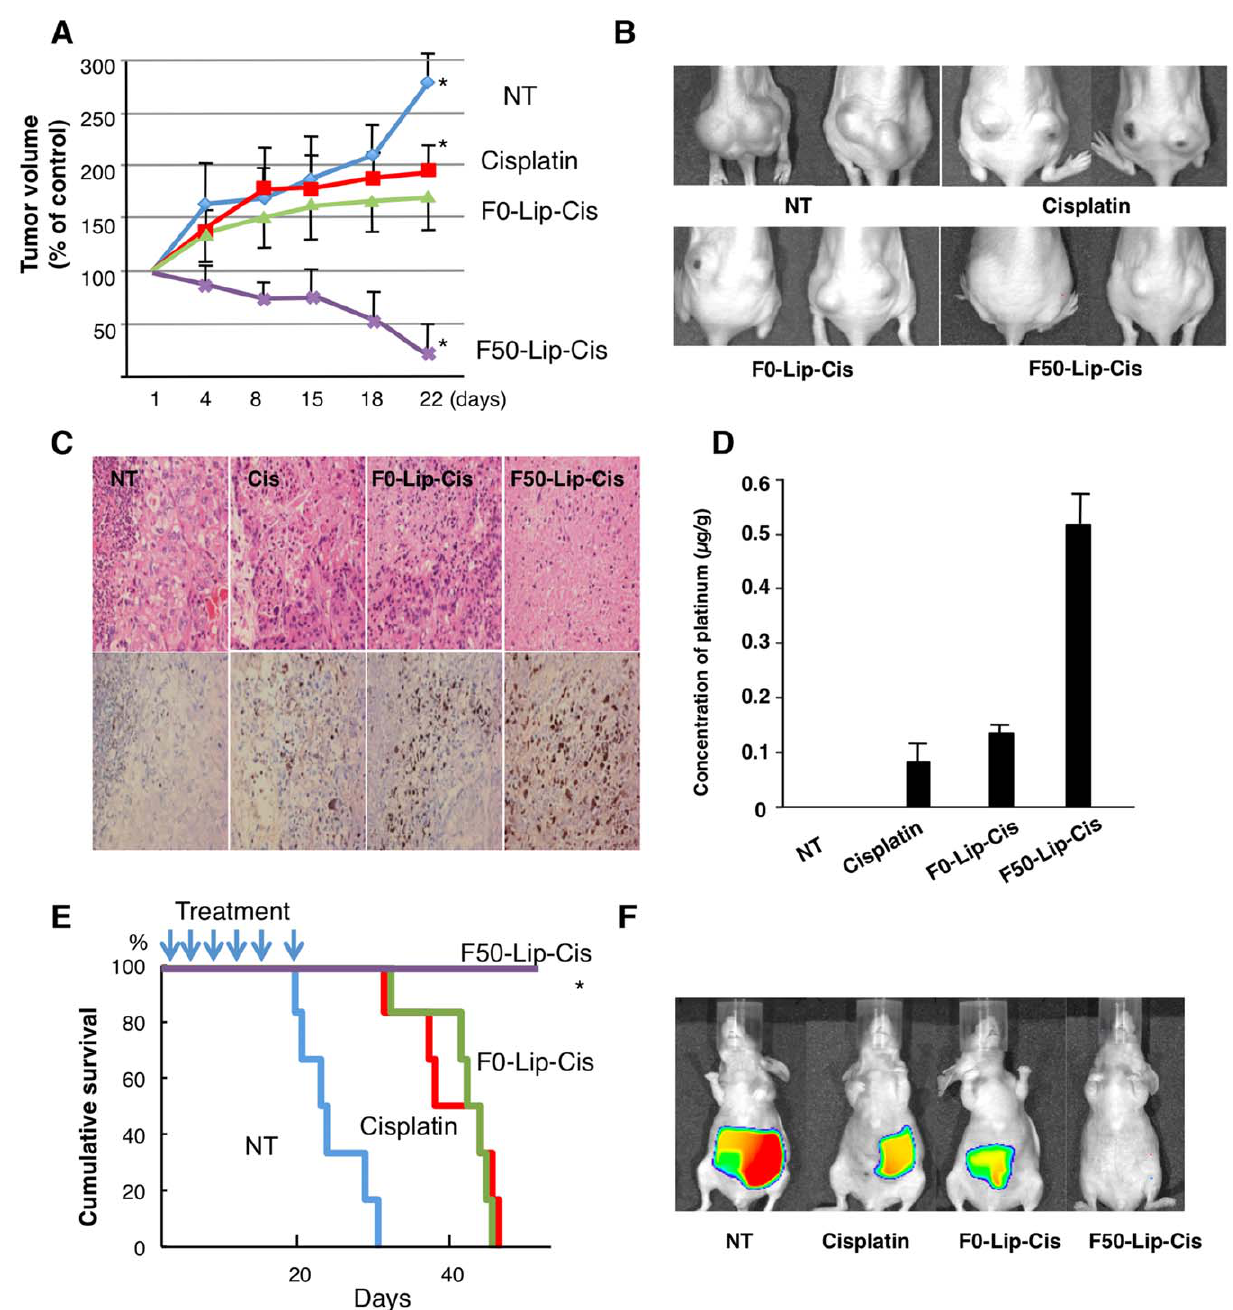
Figure 6. Fuc-liposomes carrying Cisplatin suppressed tumor growth and prolonged survival of mice in the xenograft model. ( A, B ) Comparison of tumor growth suppression with Cisplatin, F0-Liposome-Cisplatin, and F50-Liposome-Cisplatin in AsPC-1-bearing mice. Cisplatin (2 mg/ kg), F0-Liposome-Cisplatin (2 mg/kg), or F50-Liposome-Cisplatin solution (2 mg/Cisplatin/kg) was injected via the tail vein of AsPC-1-bearing mice twice a week. At 4, 8, 11, 15, 18 , and 22 days after transplantation, tumor volumes were measured. Representative image of mice treated with Cisplatin ( B ). Results are expressed as the mean 6 SD (n=6). *P , 0.01 compared with NT, Cisplatin, and F0. ( C ) Tumor tissue was prepared on day 22 after treatment. HE staining (upper panel) and TUNEL staining (lower panel) are presented. ( D ) Concentration of platinum in the tumor tissue measured by ICP. ( E ) Survival rate of the mice treated with Cisplatin alone, F0-Liposome-Ciplatin, and F50-Liposome-Ciplatin in the liver metastasis model using BxPC-3 cells. Statistical analysis was performed by generalized Wilcoxon test. *P , 0.01 compared with NT, Cisplatin, and F0. ( F ) Localization of BxPC3-Luc cells in the orthotopic model detected using an IVIS imaging system after 3 weeks of treatment. doi:10.1371/journal.pone.0039545.g006 While it has been reported that the postoperative survival rate is patients with pancreatic cancers expressing CA19-9 would be significantly worse in adenocarcinoma patients whose CA19-9 appropriate candidates for treatment with Fuc-liposomes carrying anticancer drugs.